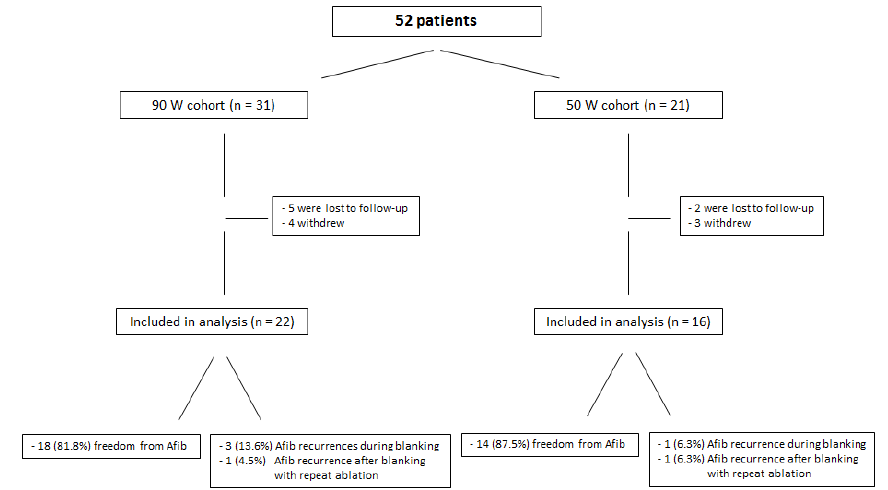
Figure 5. Detailed flow-chart overview of study population.